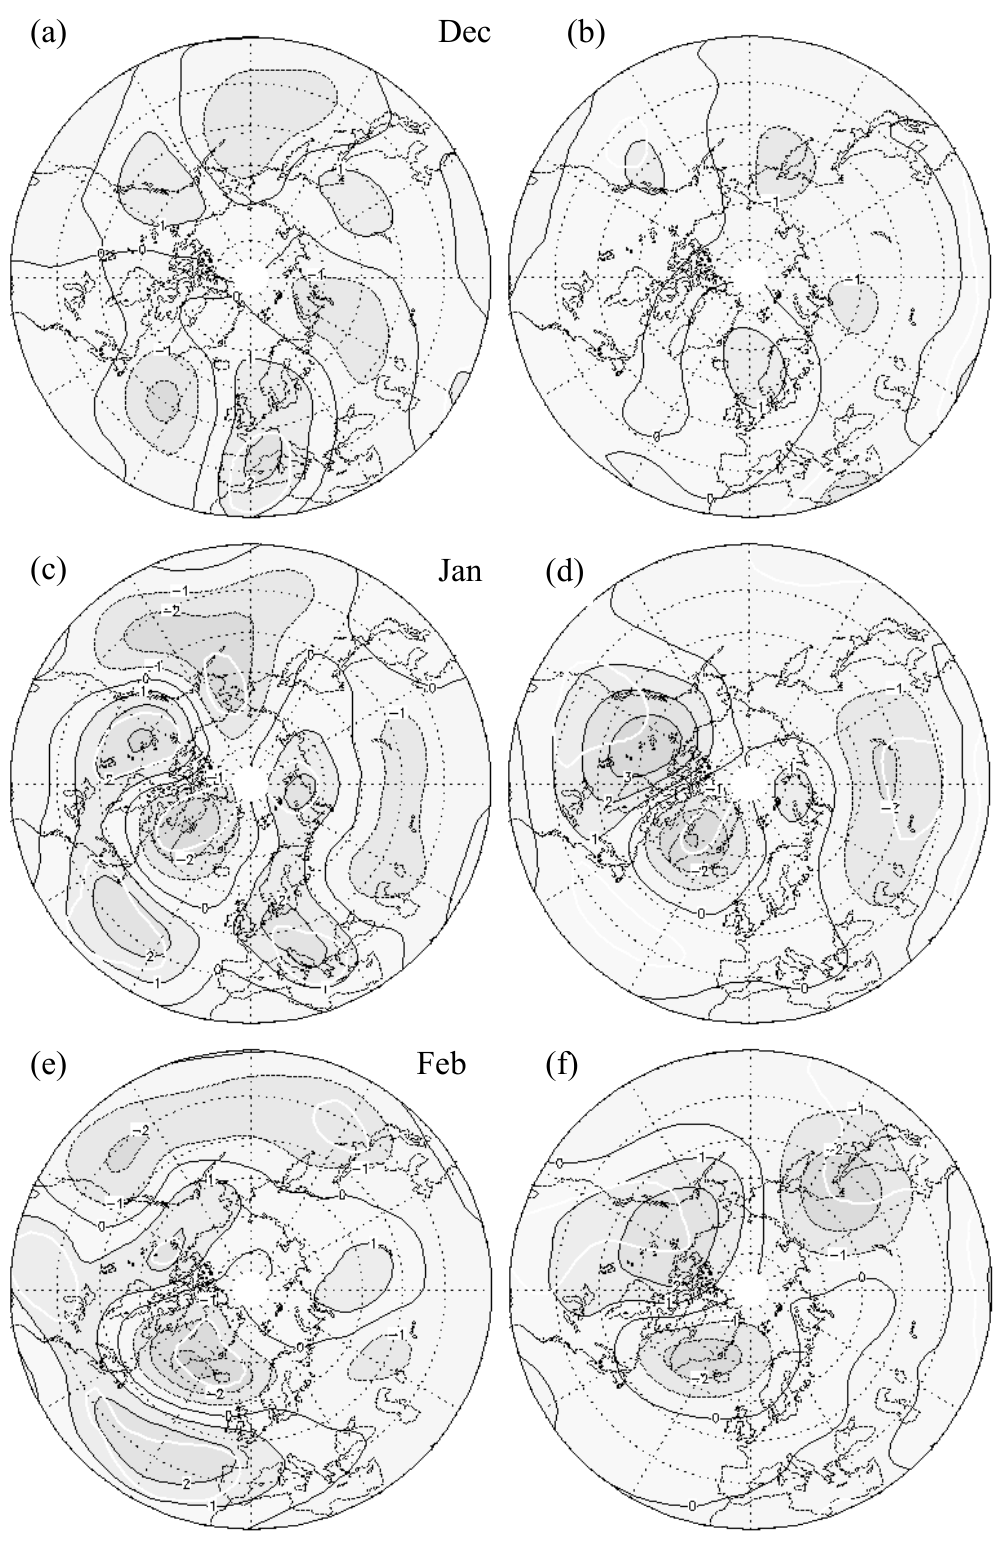
Fig. 7. Mean geopotential height trends at 300hPa (left column) and at 70hPa (right column) for winter months during the 1960–2000 period, for December (a, b) , January (c, d) , February (e, f) Figure 7: Mean geopotential height trends (m/yr) at 300 hPa (left column) and at 70 hPa (right column) for winter months during the 1960-2000 period for December (a, b), January (c, d), and February (e, f).